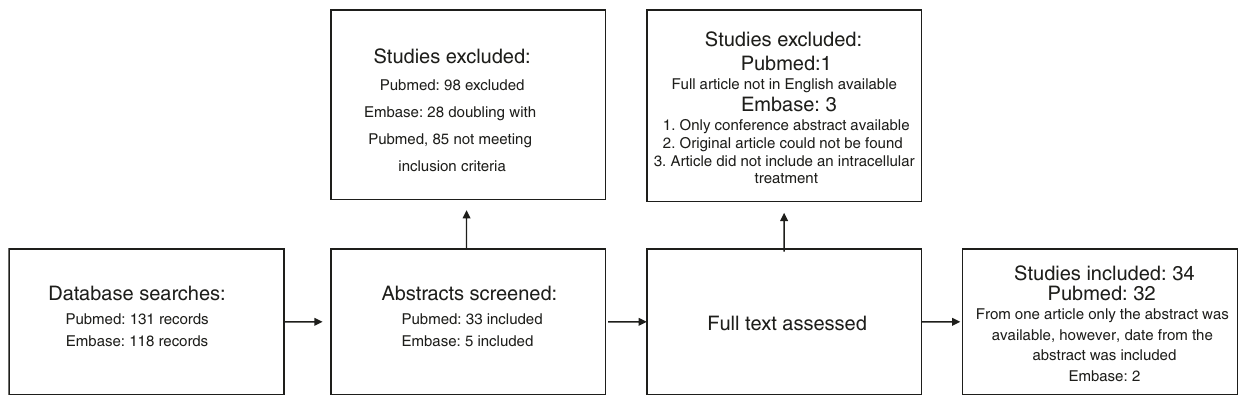
Fig. 1 Schematic representation of the literature screen performed. Four articles are not included in the tables, since they did not measure the reduction of the number of colony-forming units (CFU) by the antibiotic as an